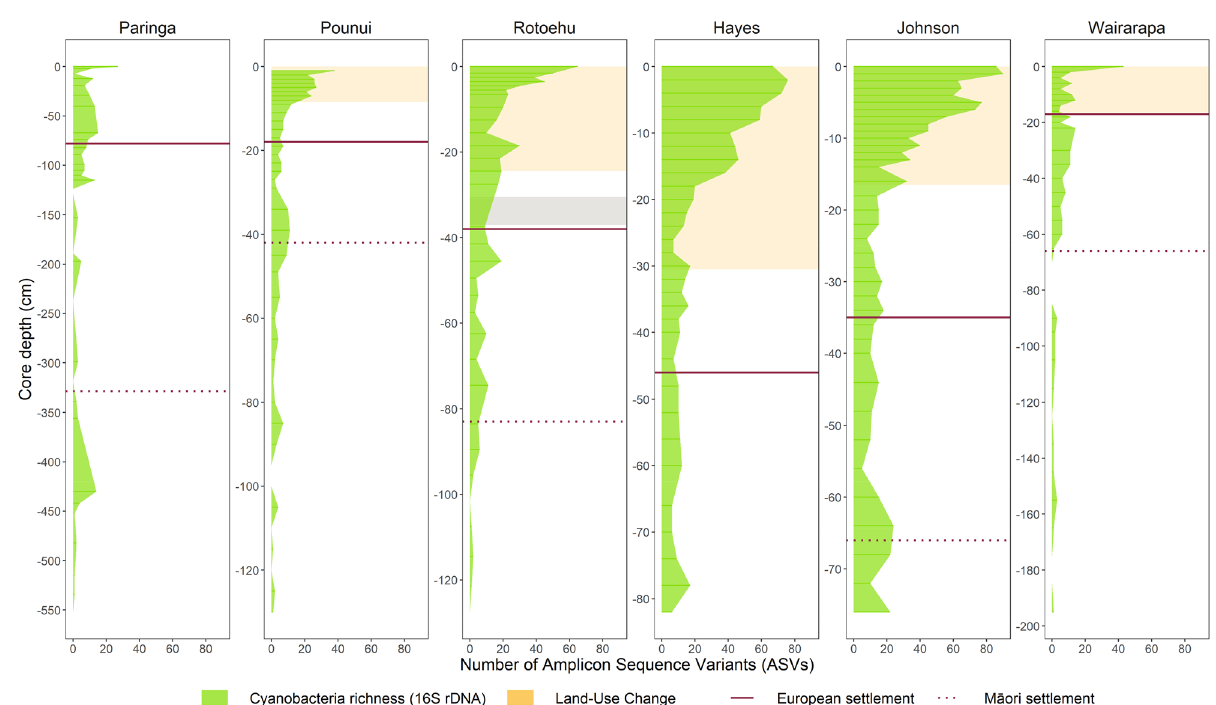
Figure 2. Richness of photosynthetic cyanobacterial Amplicon Sequence Variants (ASVs) from metabarcoding data, cyanobacterial 16S rRNA gene. The horizontal lines separate the three phases, pre-human (PH; bottom), evidence of Māori settlement (EMS; middle), and post European settlement (PES; top); note: the sediment core from Lake Hayes does not include any PH phase. Yellow shades indicate the depths associated with land-use intensification in relevant lakes and the grey shade indicates the 1886 Tarawera tephra layer in Lake